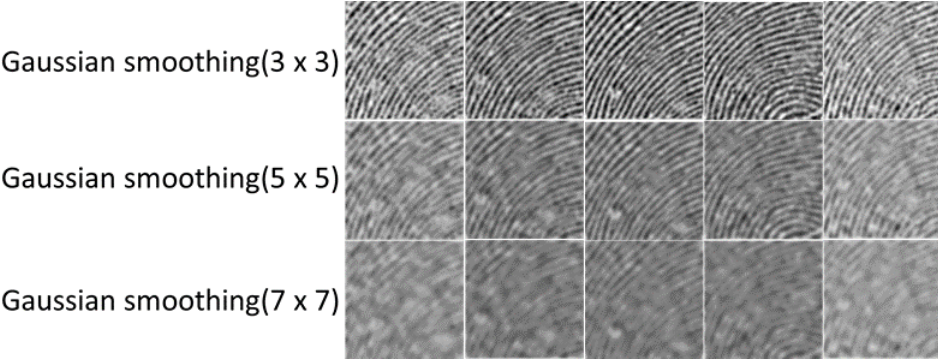
Figure 5. Fingerprint images with three different levels of blurring.